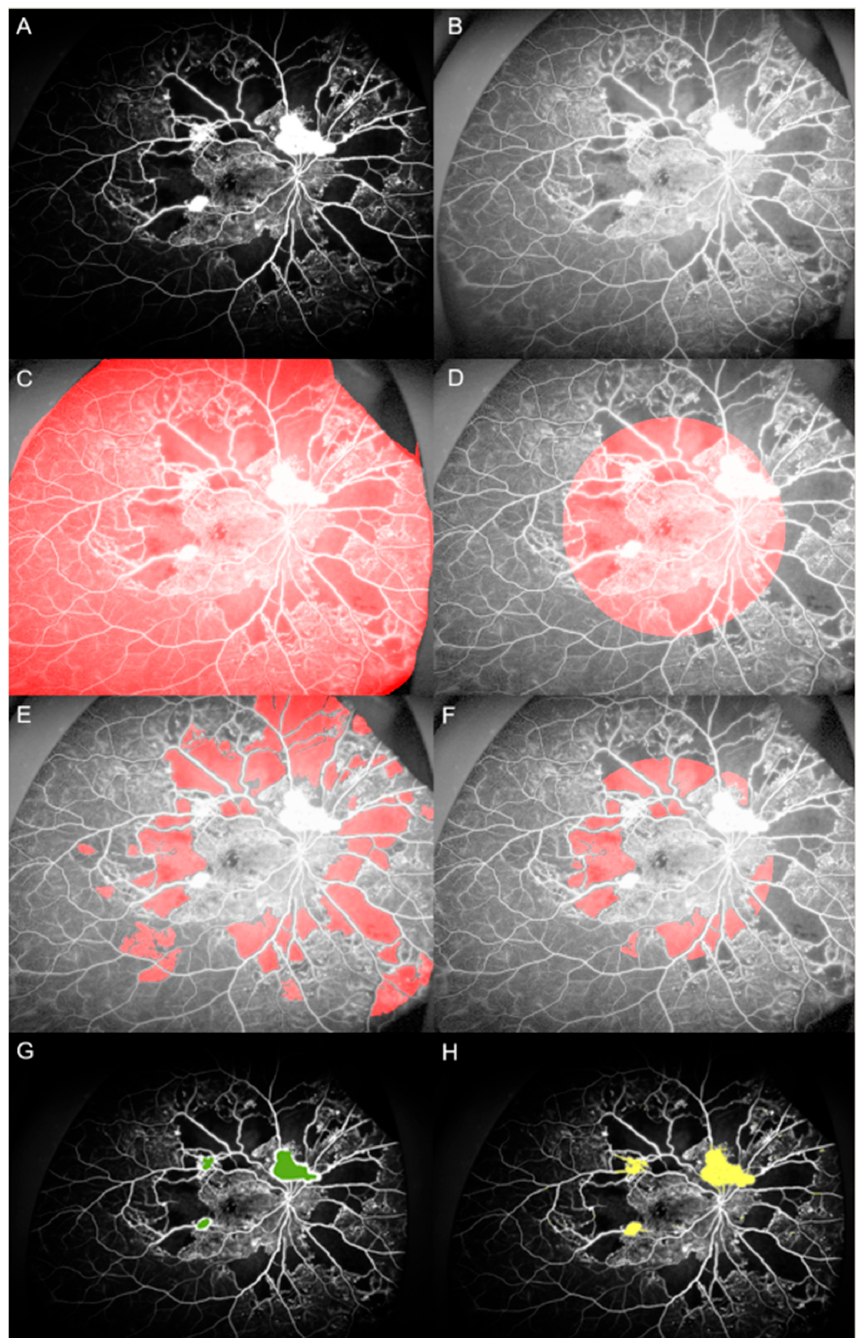
Figure 1. Assessment of nonperfusion area and neovascularization area with ultra-widefield fluorescein angiography. ( A ) Selected fluorescein angiography (FA) images were exported as an uncompressed Bitmap file. ( B ) The saved images were opened in MATLAB and preprocessed using homomorphic filtering for illumination correction. ( C , D ) Two regions of interest were manually selected: total gradable retina and the posterior pole. ( E , F ) The image was then segmented automatically and the nonperfusion area (NPA) was selected using a threshold of area properties. The selected NP area underwent a final manual modification. ( G , H ) Measurement of the neovascularization area was performed in a semiautomated manner using the Graph Cut and Active Contour functions in the MATLAB Image Segmenter